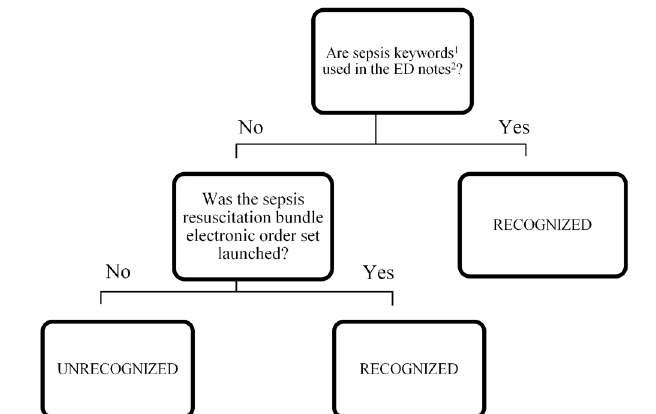
Figure 1. Algorithm for retrospective identification of sepsis recognition by emergency